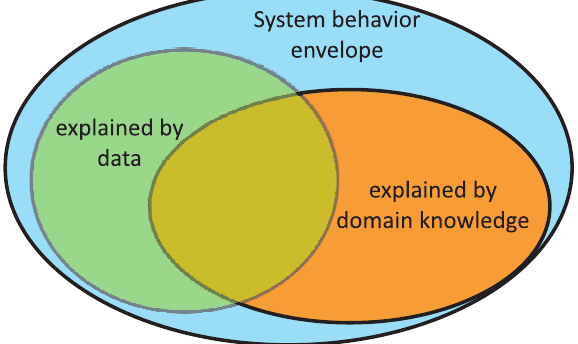
Figure 2. Understanding a system’s behavior on the basis of domain knowledge and data.